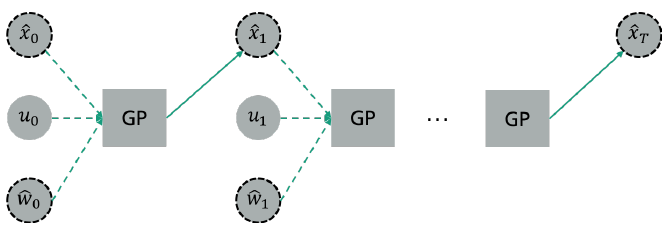
Figure 4. An off-line trajectory rollout using the identified GP state-space